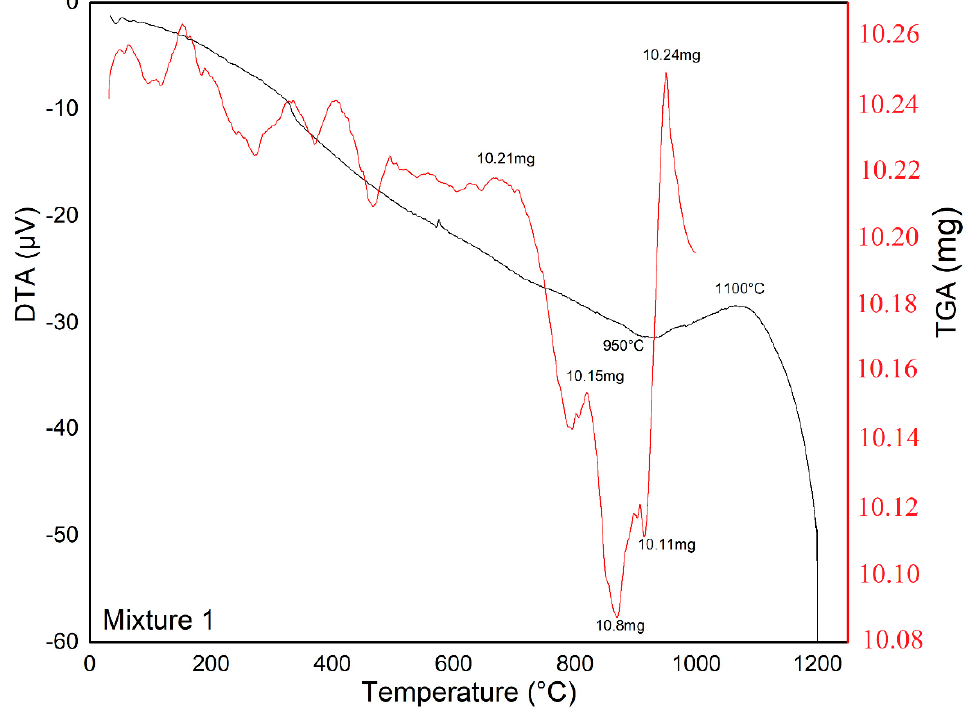
Figure 8. Thermal analysis (DTA-TGA) between 25 and 1200 °C for Mixture 1 showing characteristic temperatures.